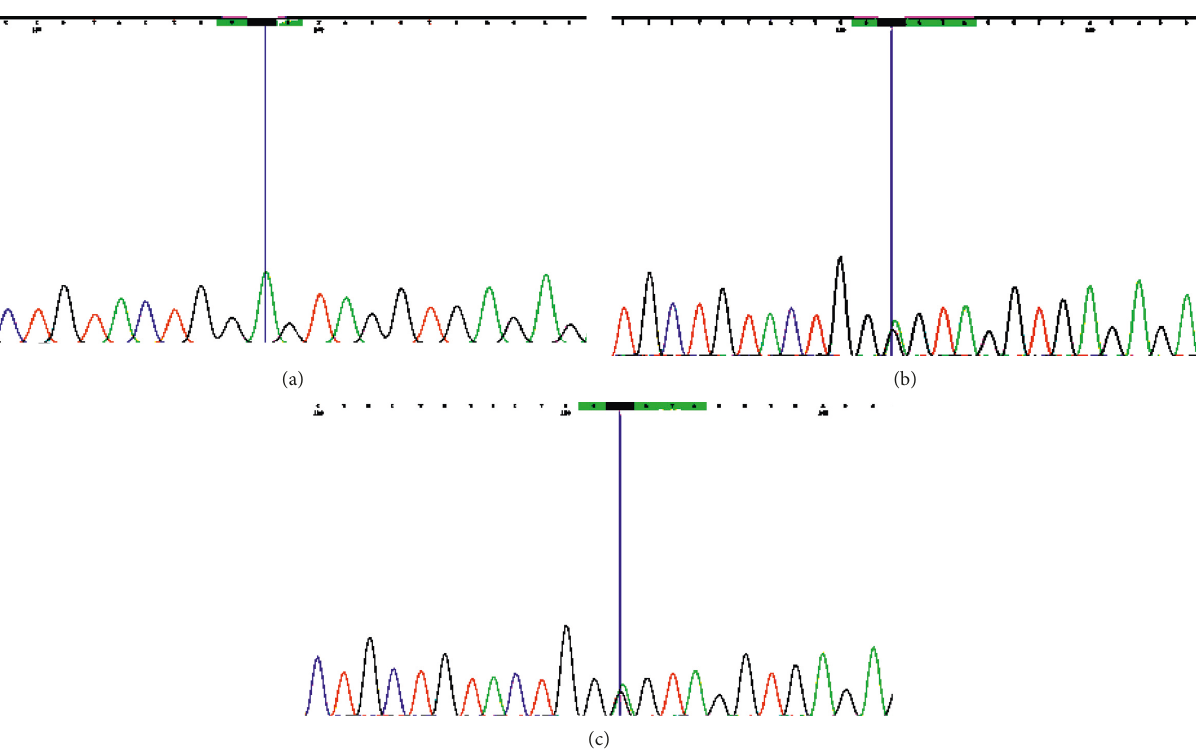
Figure 2: (a) Sanger sequence chromatogram of the proband showing a novel homozygous missense mutation in exon 5 of the eukaryotic translation initiation factor 2B subunit delta ( EIF2B4 ) gene, ENST00000493344: c.614C > T [p.Pro205Leu] causing leukoencephalopathy with vanishing white matter (VWM). (b) Mother of the proband with a heterozygous mutation. (c) Father of the proband with a het- erozygous